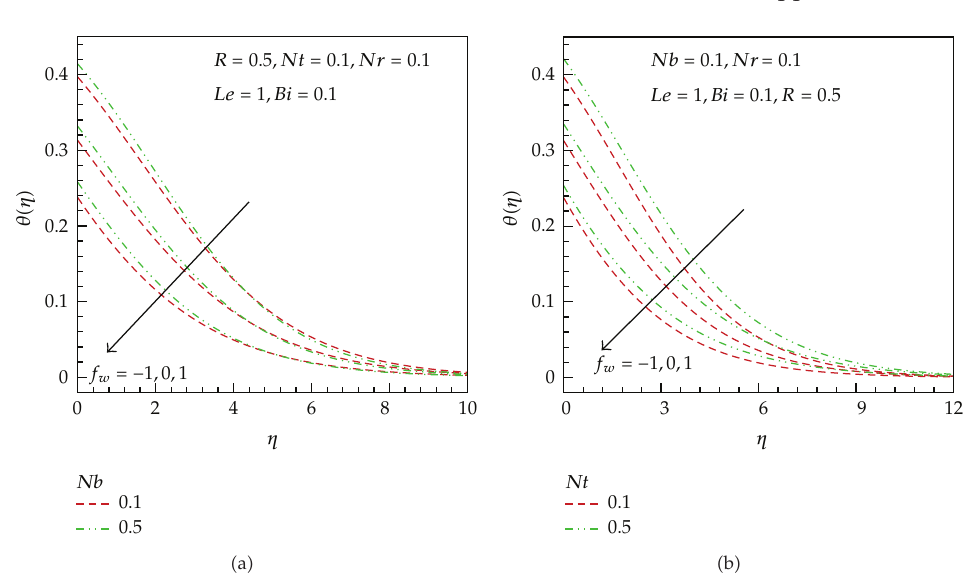
Figure 5: E ff ect of (cid:3) a (cid:4) Brownian motion parameter, (cid:3) b (cid:4) thermophoresis parameter on the dimensionless temperature for di ff erent values of suction/injection